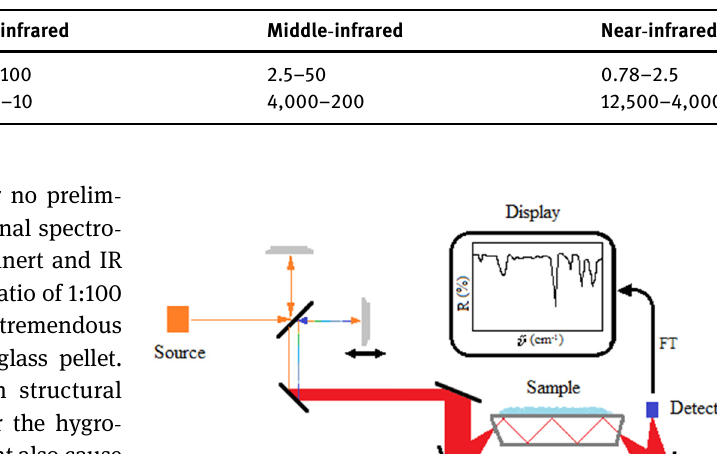
Table 1: List of infrared regions